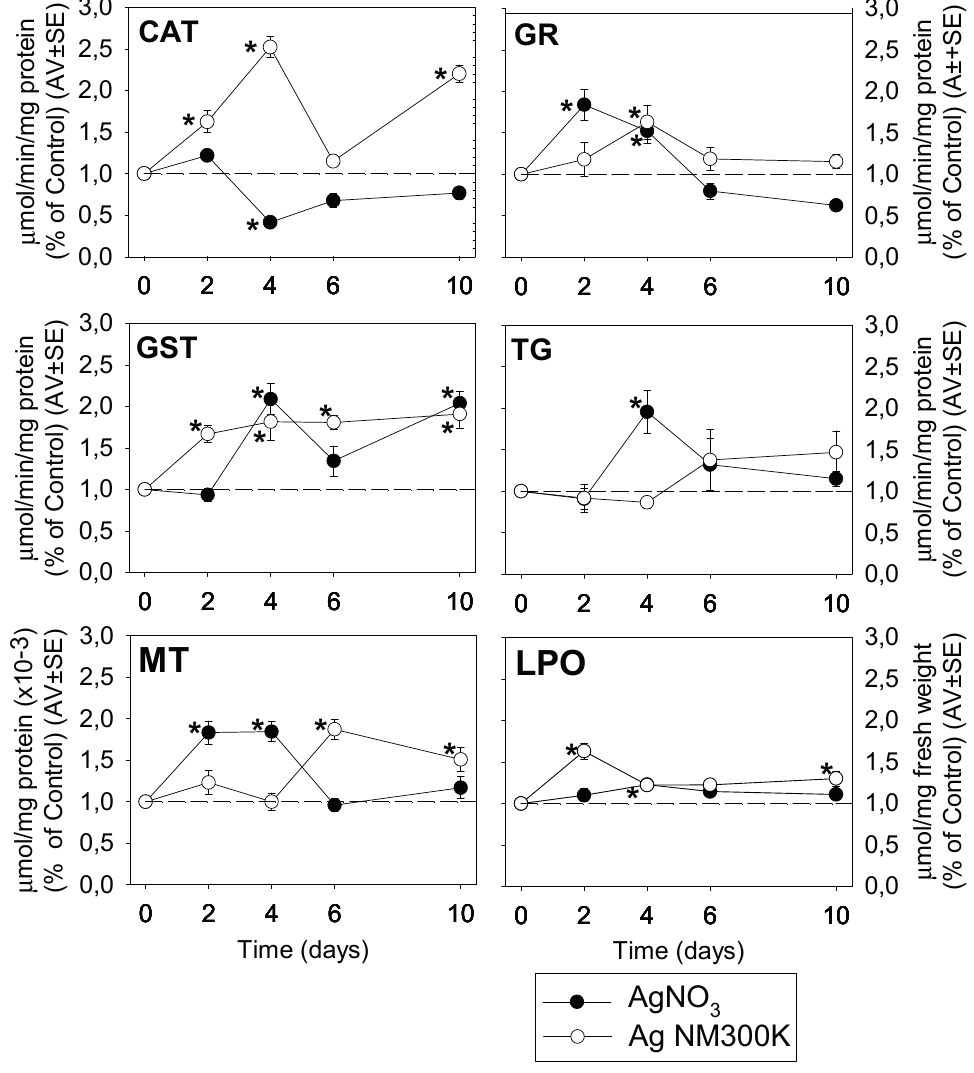
AgNO Figure 2. Oxidative stress biomarker results for Folsomia candida when exposed in LUFA 2.2 soil to the reproduction EC 50 of AgNO 3 (black dots) and Ag NM 300K (white dots). Results are expressed as % and normalized to the respective controls (water and dispersant) mean values ± standard error (Av ± SE) ( n = 5). Dotted horizontal line represents the control reference, i.e. , 100%. CAT: Catalase; GR: Glutathione Reductase (GR), GST: Glutathione S-Transferase, TG: Total Glutathione; MT: Metallothionein; LPO: Lipid Peroxidation; * : Dunnett’s test ( p < 0.05) for differences between control and treatments.